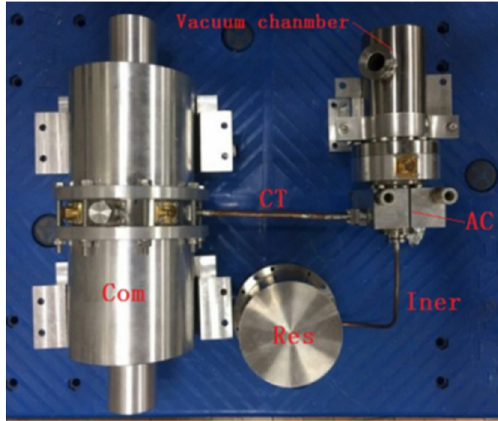
Figure 10. 170 K pulse tube cryocooler 25